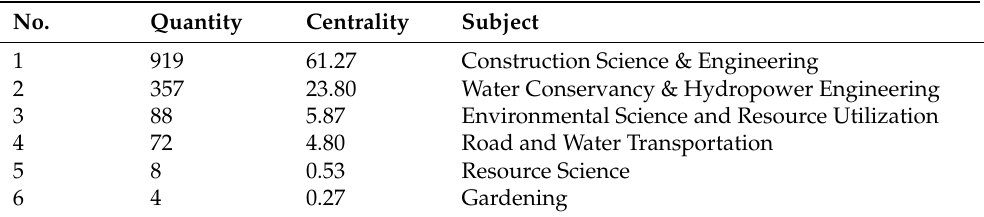
Table 2. The subject categories of the LID research based on the CNKI